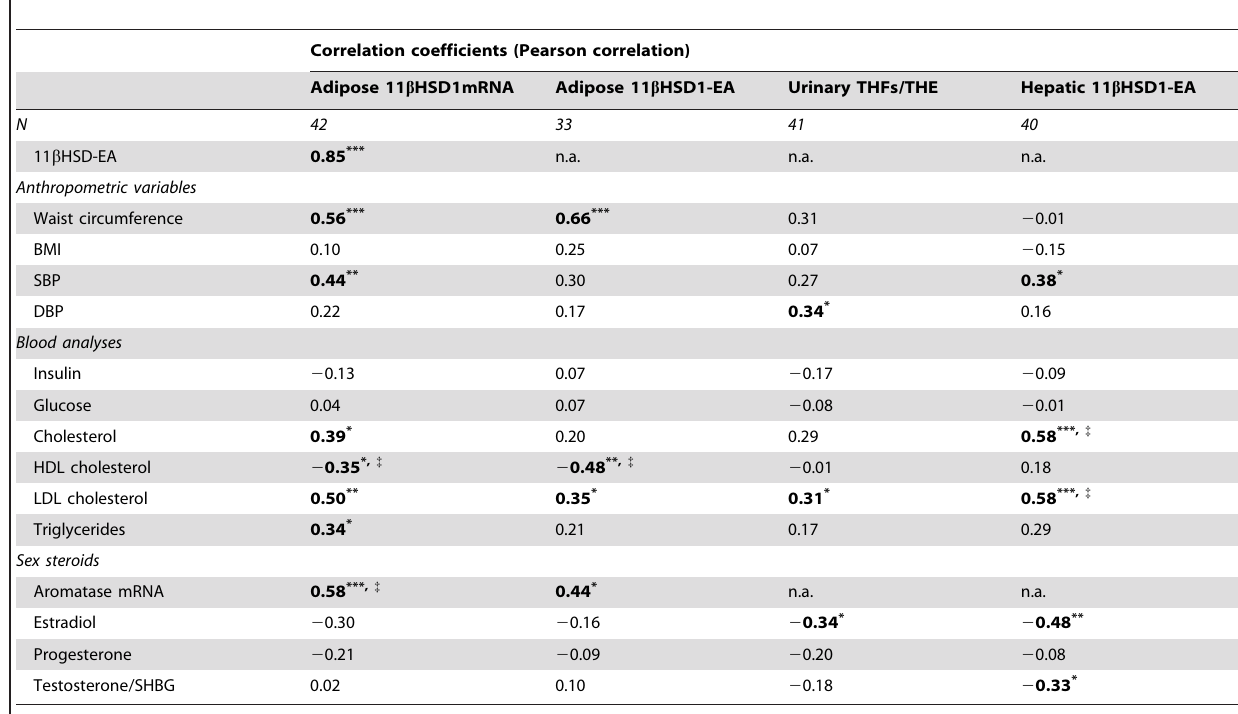
Table 4. Bivariate correlations for adipose 11 b HSD1 expression and activity, urinary THFs/THE and hepatic 11 b HSD1 activity versus anthropometric data, sex steroids, hormones and gene expression of